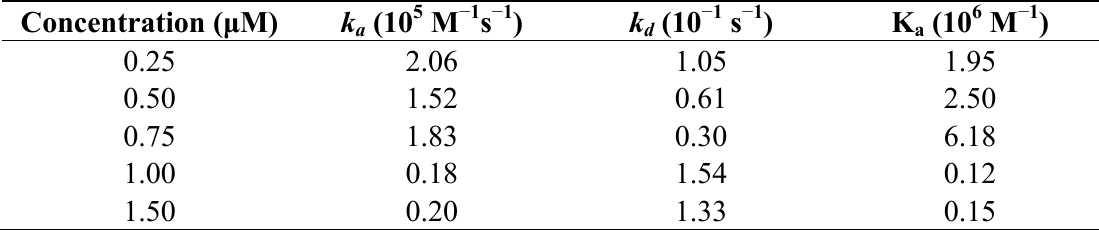
Table 2. TBA and thrombin interaction kinetic constants. The constants were calculated using the real-time sensorgram in Figure